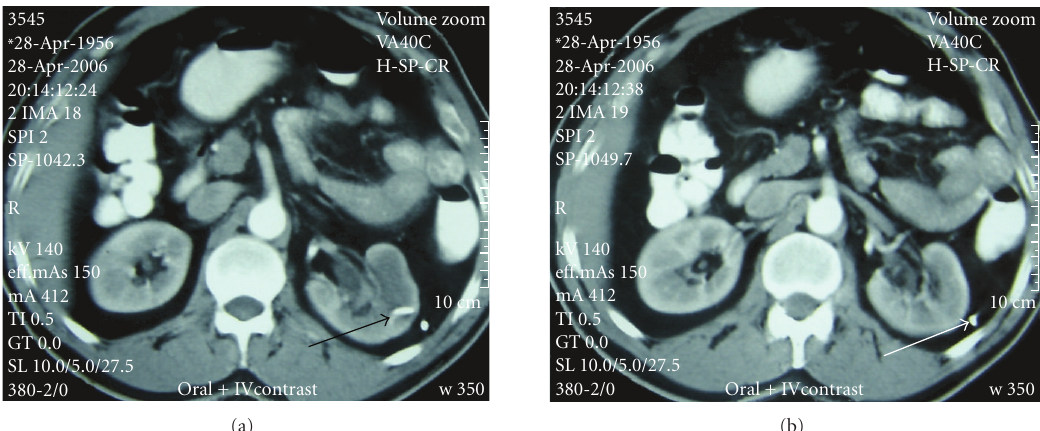
Figure 5: Six weeks after treated with CRS-technique. Black arrow: renal cyst component of CRS-catheter. White arrow: retroperitoneal component of